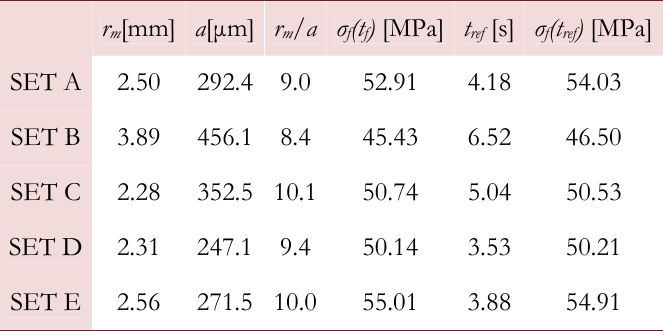
Table 4: Mean values of the failure parameters, failure strength, time reference and inert strength for each series.